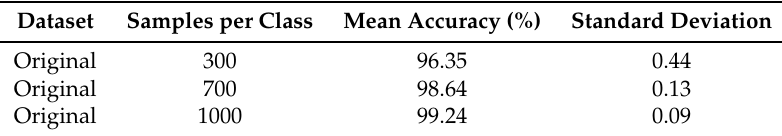
Table 4. Deep Learning experiments with the original database.